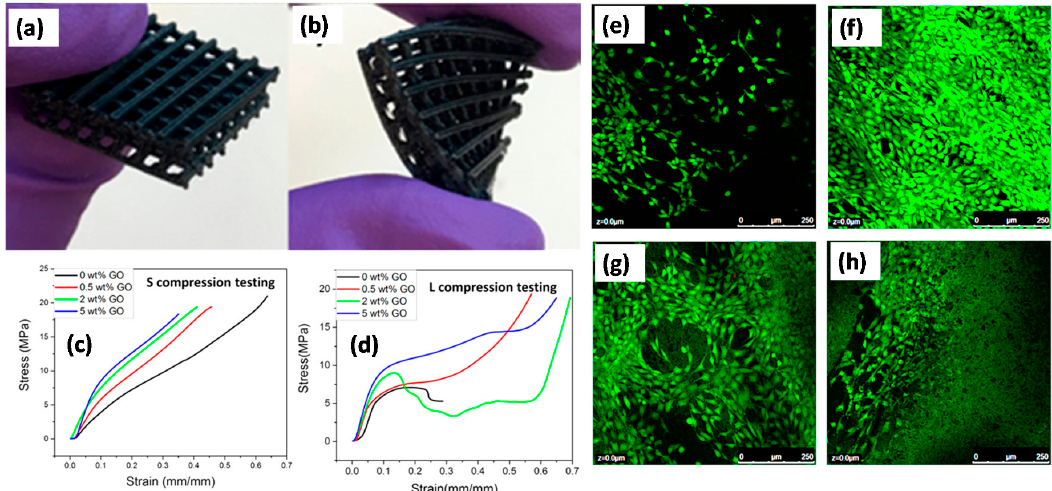
Figure 24. ( a ) 3D printed microlattice (5 wt% of GO); ( b ) 3D printed microlattice under bending (5 wt% of GO); ( c ) S Compression testing curves of samples of different GO loadings; ( d ) L Compression testing curves of samples of different GO loadings. 96 h cell culture results of NIH3T3 cells on 3D printed TPU/PLA with different GO loadings: ( e ) 0 wt% GO; ( f ) 0.5 wt% GO; ( g ) 2 wt% GO; ( h ) 5 wt% GO. Green color indicates live cells, whereas red color indicates dead cell [83].